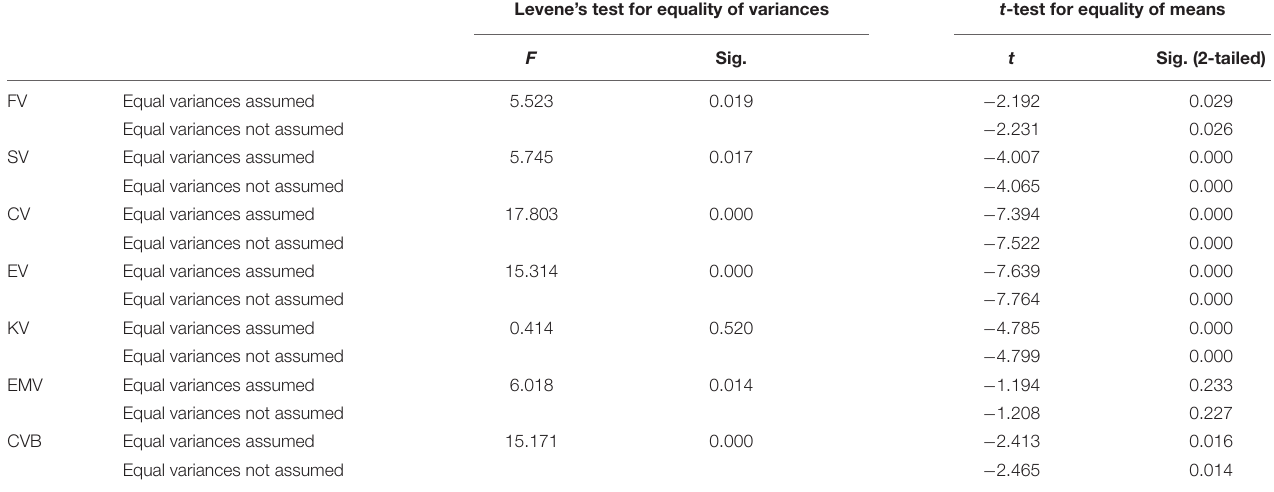
TABLE 4 | Independent samples t -test.